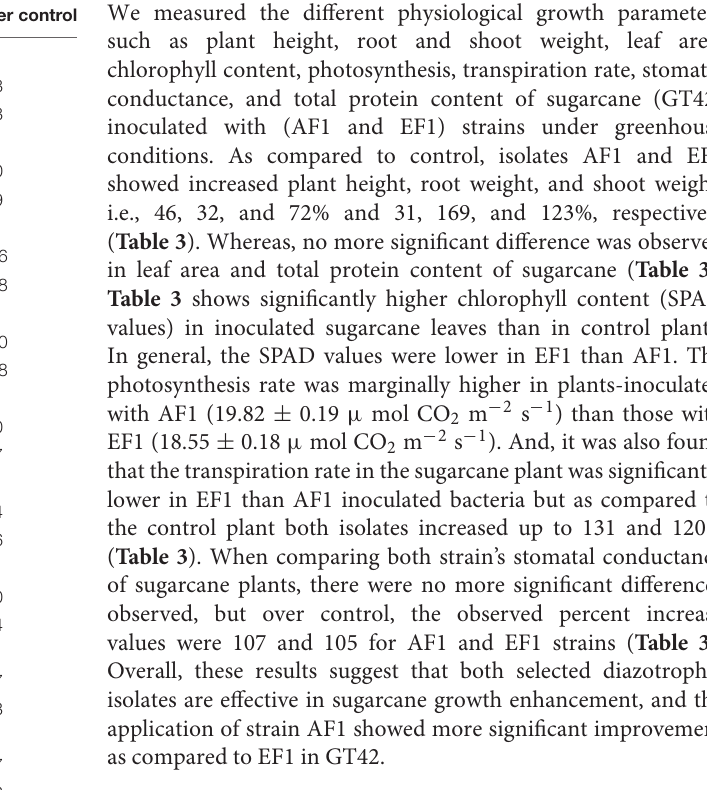
TABLE 3 | The assessing of diazotrophic endophytes Pantoea cypripedii AF1 and Kosakonia arachidis EF1 inoculum on the sugarcane (variety GT42) in the greenhouse